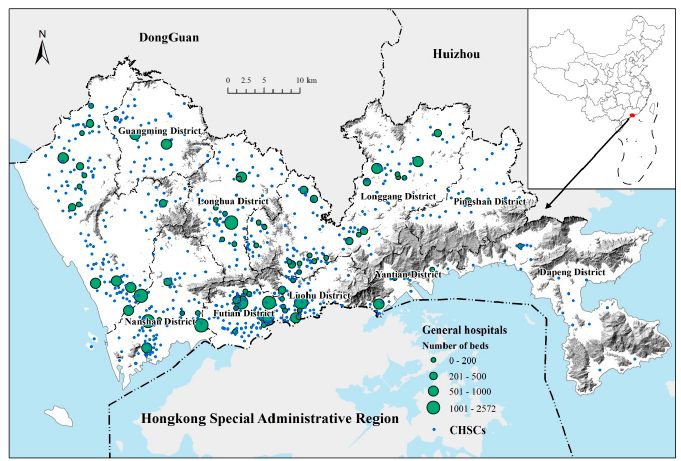
Figure 1. The overview of Shenzhen city.